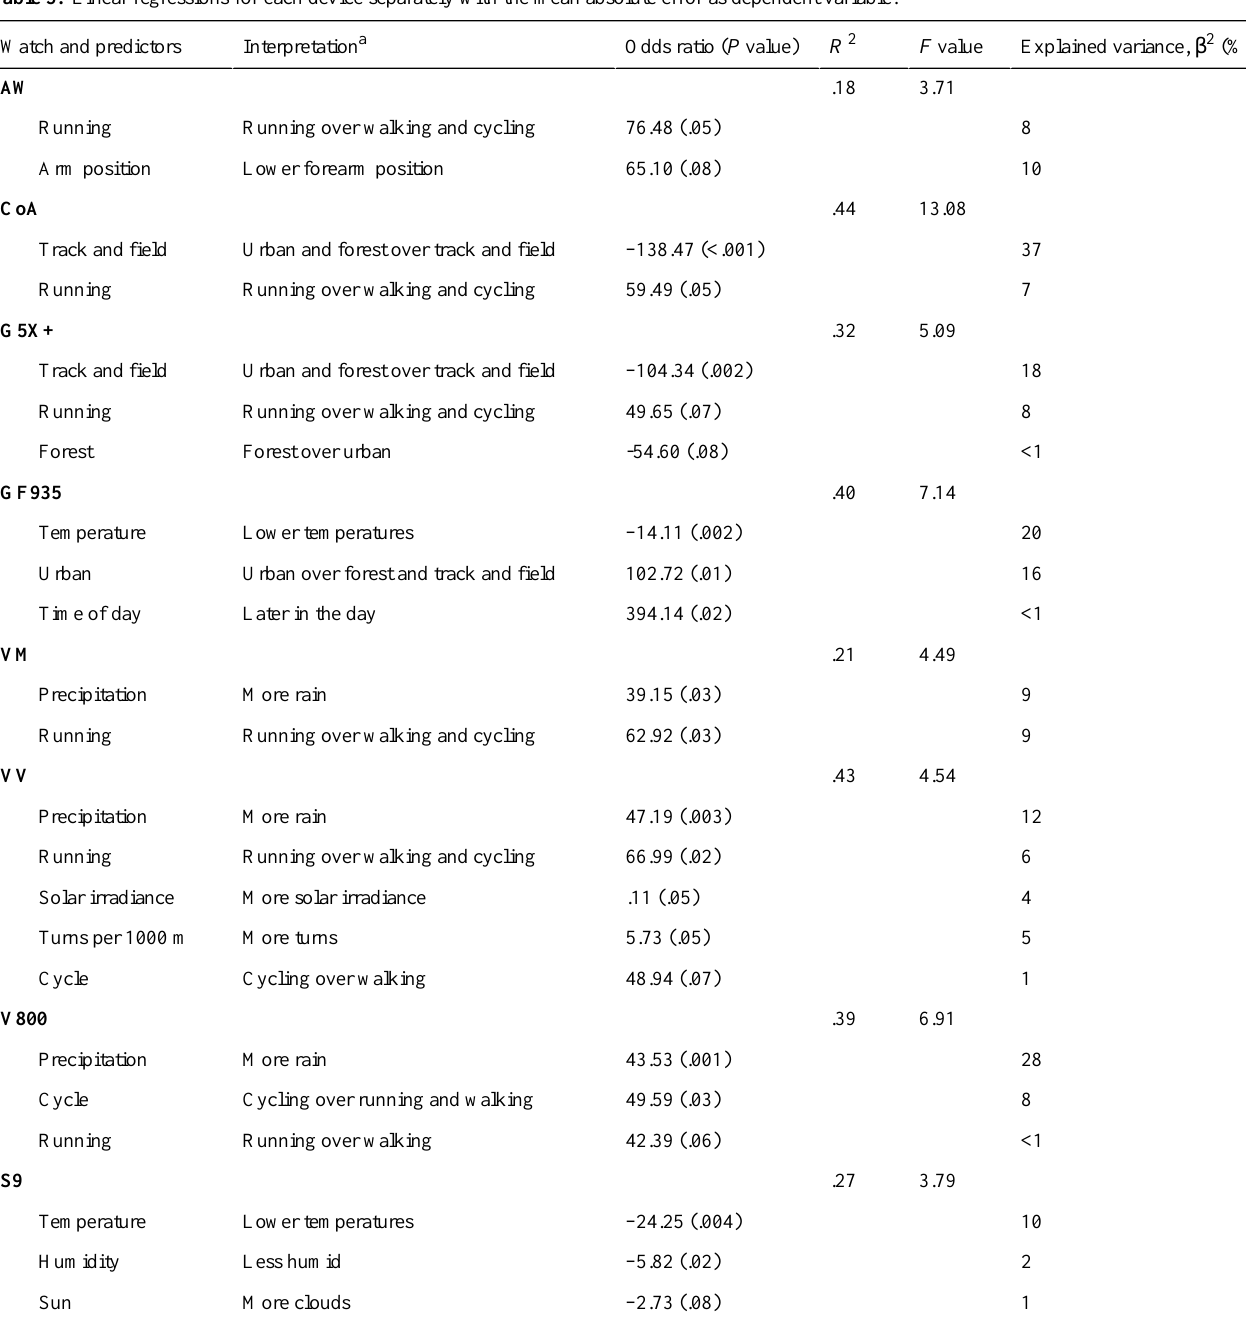
Table 5. Linear regressions for each device separately with the mean absolute error as dependent